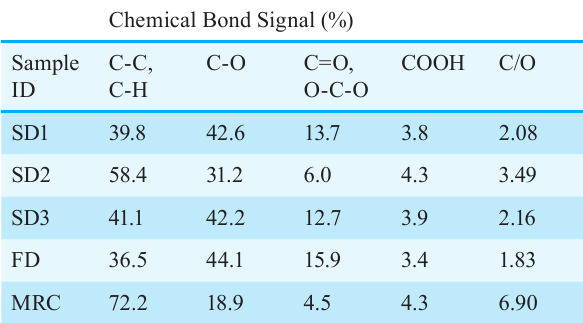
Table 3 Examples of surface modified powders. Table 4 XPS surface bond composition.